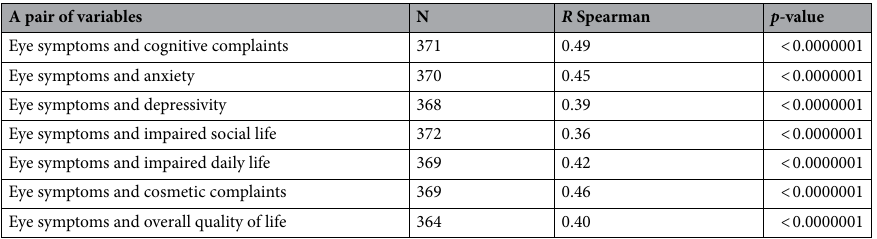
Table 3. Results of the correlation of scores of “eye symptoms” section with other scales of ThyPROpl questionnaire (sugerowane usunięcie – wg recenzenta nie pasuje do koncepcji artykułu). N the number of valid answers, R Spearman Spearman’s R test result.